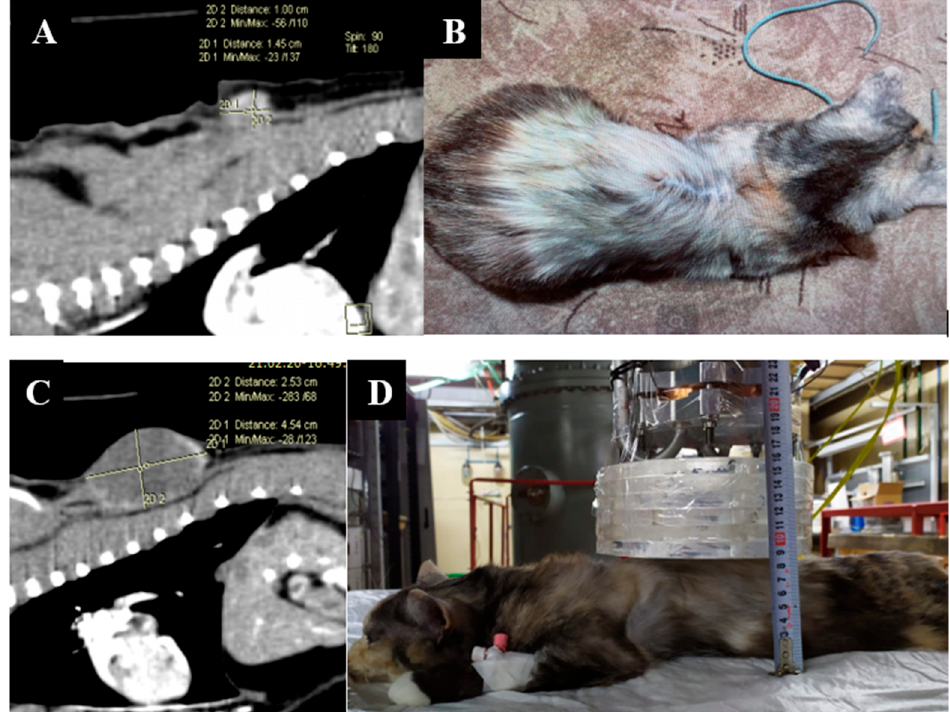
Figure 3. A cat named “Kira”. ( A )—CT scan of the chest cavity, tumor of the soft tissues of the back before surgical treatment. ( B )—condition after surgical treatment. ( C )—Recurrent tumor of the soft tissues of the back. ( D )—positioning of the animal during the repeated irradiation session.